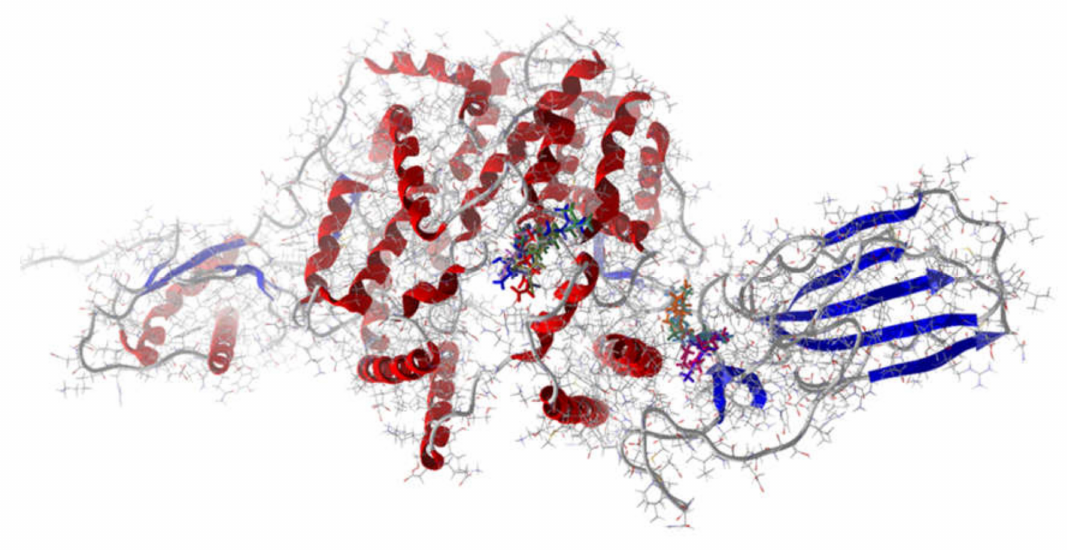
Figure 6. Lowest-energy docked ligands with the binding domain of SARS-CoV-2 spike protein and human angiotensin-converting enzyme 2 (ACE2) (PDB: